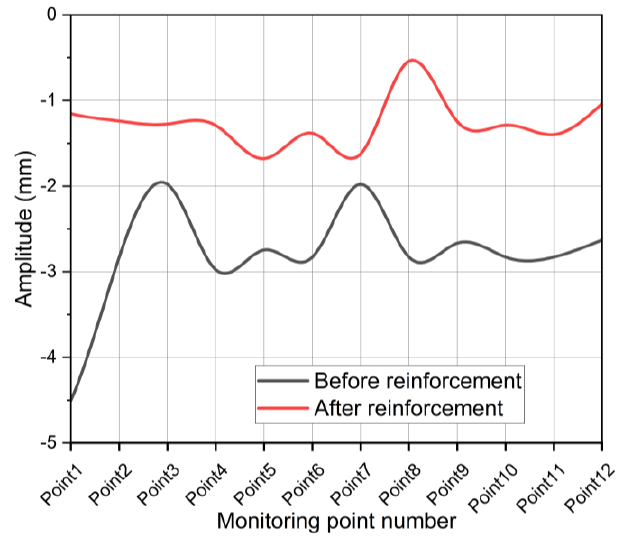
Figure 14. Comparison of minimum amplitude before and after reinforcement.